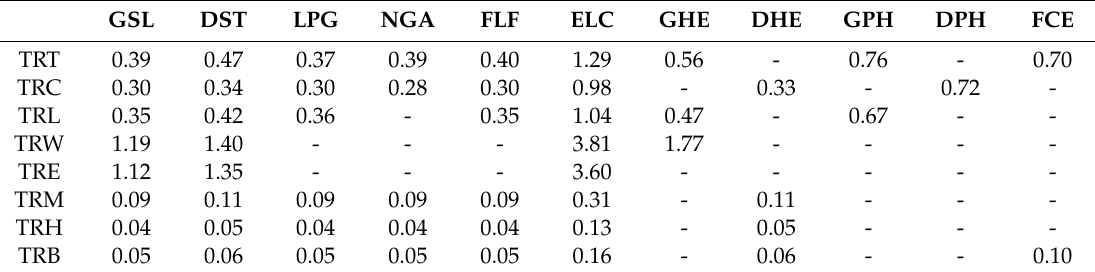
Table 6. Efficiency (in (cid:1828)(cid:1874)(cid:1863)(cid:1865)/(cid:1842)(cid:1836) ) for the different modes/technolgies in the current road transport module.